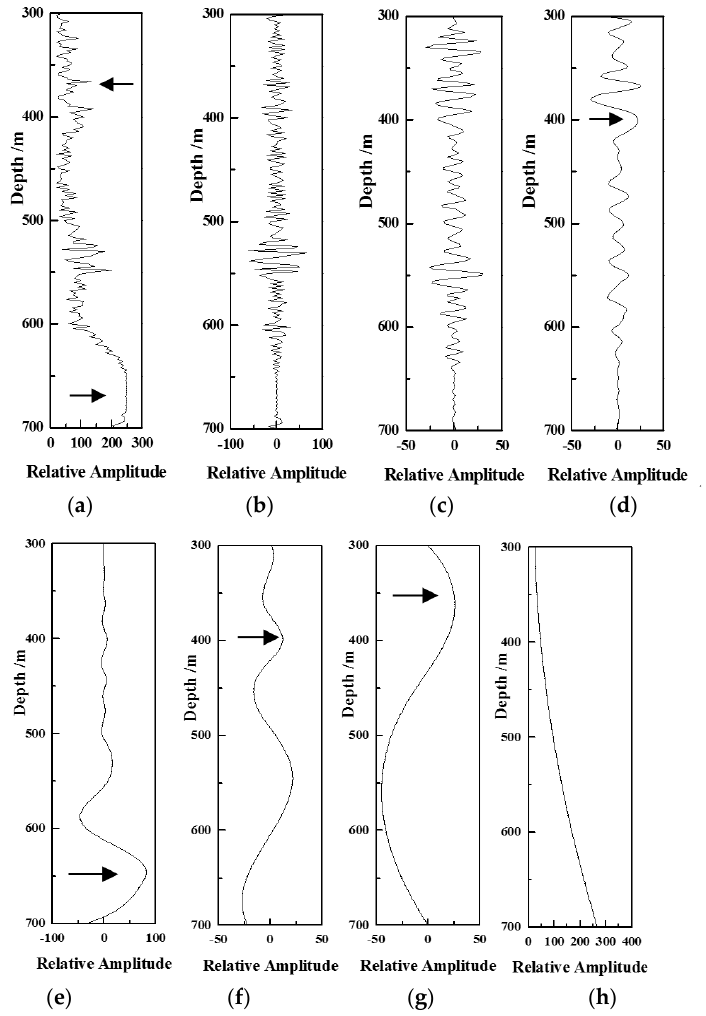
Figure 11. Empirical mode decomposition results of the measured magnetic amplitude curve. ( a ) Raw magnetic amplitude curve. ( b – g ) First to seventh eigenmode functions. The last ( h ) represents the residual component of the empirical mode decomposition. Note: The wave packet near 400 m with the arrow points corresponds to 250 Hz power frequency noise, while the wave packet near 660 m corresponds to 150 Hz power frequency interference noise.